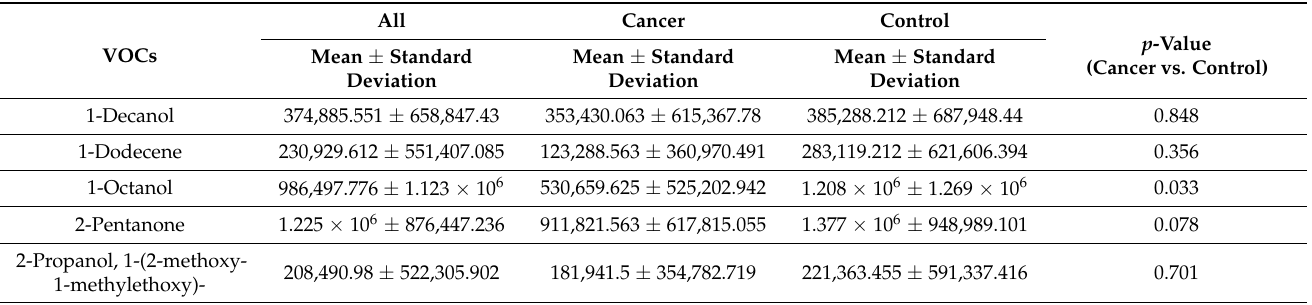
Table 2. Descriptive analysis of the VOC expression/level between cancer and control groups ( p -value < 0.05 is considered signi fi cant).